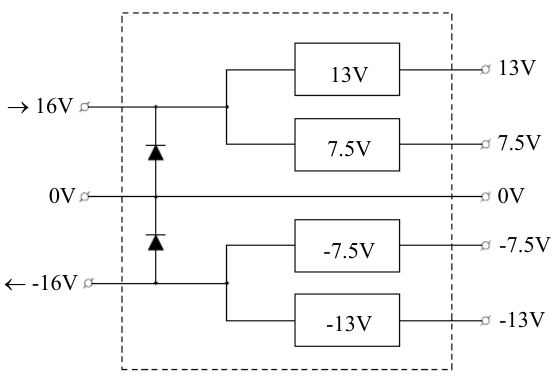
Figure 7. Schematic of the “Power supply” module.